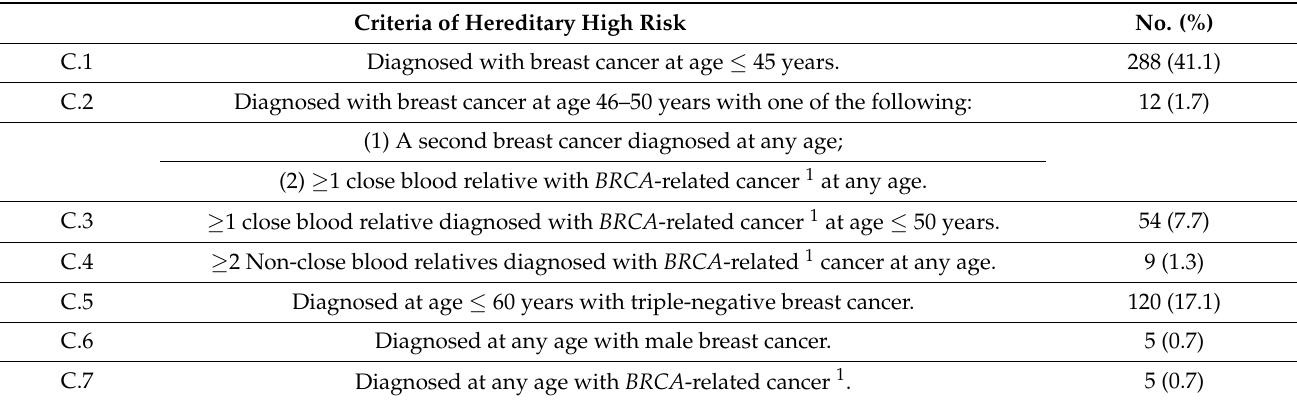
Table 2. Selection criteria and numbers for the patients at hereditary high risk.